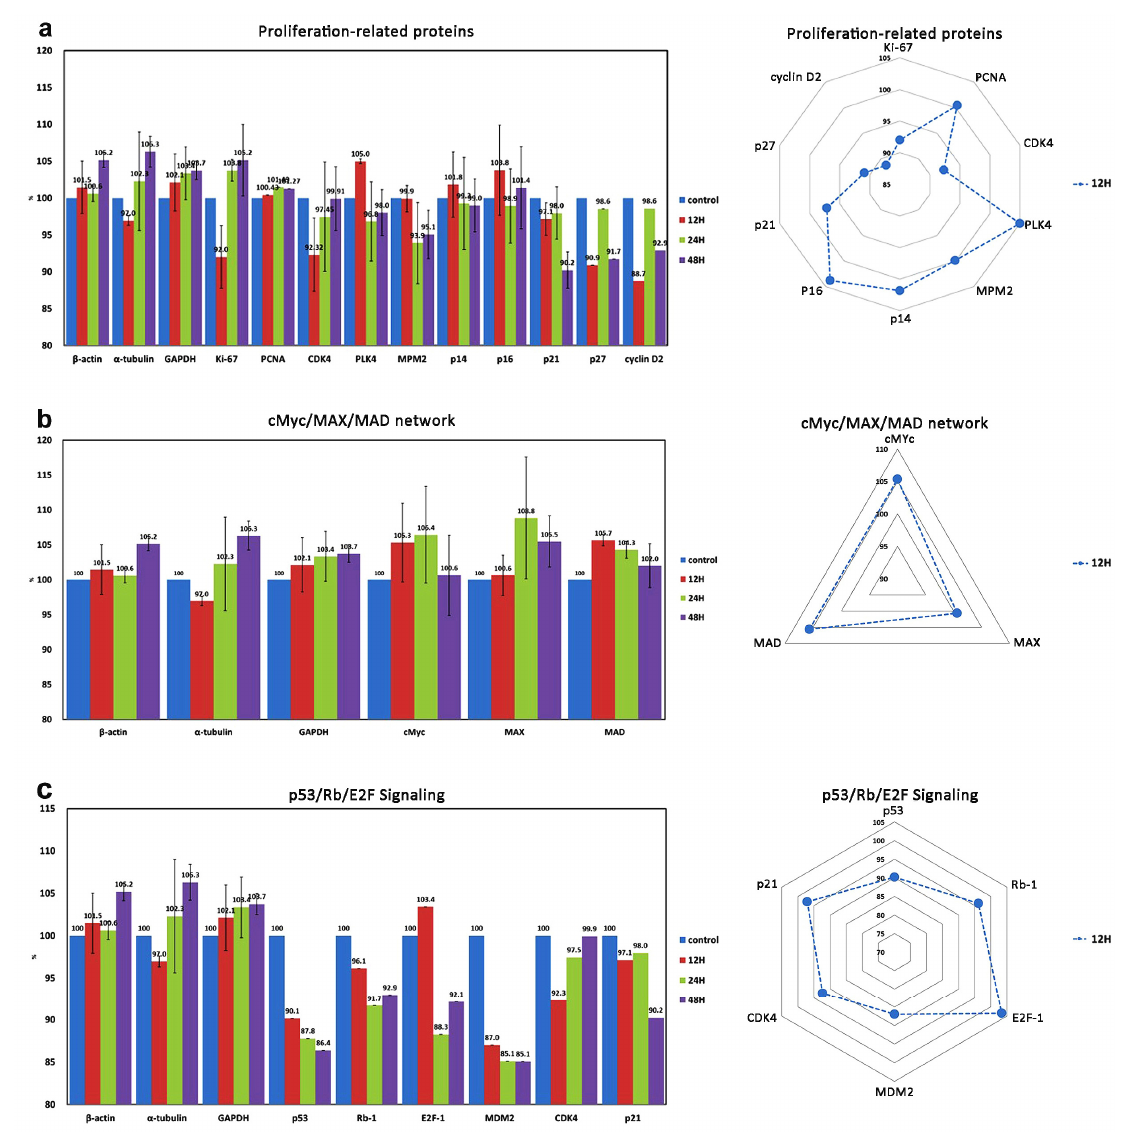
Figure 1. ( a ) Changes of proliferation-related proteins after PTX treatment in RAW 264.7 cells; ( b ) changes to cMyc/MAX/MAD signaling proteins after PTX treatment in RAW 264.7 cells; ( c ) changes to p53/Rb/E2F signaling- related proteins after PTX treatment in RAW 264.7 cells. Left-sided graph shows changes of protein expressions according to the application time of PTX, blue bar; control group, red bar; 12 h treatment of PTX, green bar; 24 h treatment of PTX, purple bar; 48 h treatment of PTX. Right-sided polygonal graph shows protein expression profiles after 12 h treatment of PTX. Expression of cMyc/MAX/MAD signaling proteins . Slightly increased expression of cMyc (106.4%) and MAX (108.8%) is expressed in samples treated for 24 h. The expression level of MAD (105.7%) also increased slightly after treatment for 12 h. PTX slightly en- hanced cMyc/MAX signaling and participated in transcriptional control in RAW 264.7 cells (Figure 1b). Expression of p53/Rb/E2F signaling proteins . Expression of p53 (86.4%), Rb-1 (91.7%), E2F-1 (88.3%), MDM2 (85.1%), CDK4 (92.3%), and p21 (90.2%) is shown. PTX inhibits p53/Rb/E2F signaling leading to cellular proliferation (Figure